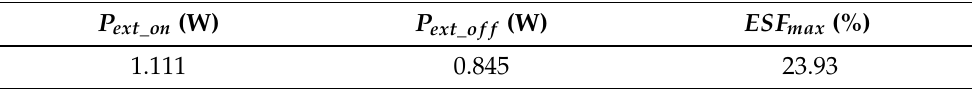
Table 3. AP ’s consumed power and maximum power saving factor